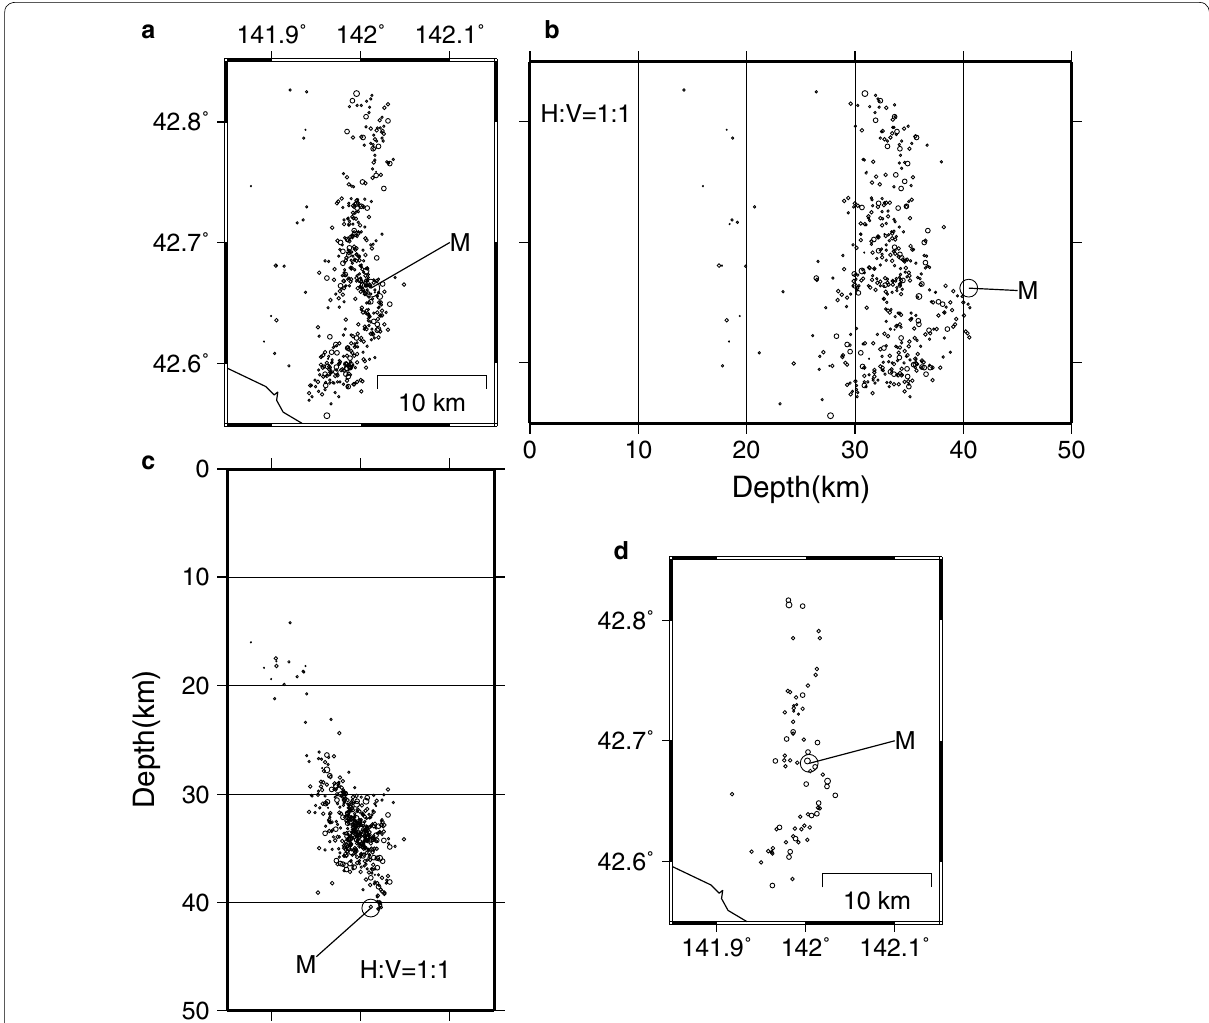
Fig. 2 Hypocenter distribution of the main shock and the aftershocks. a Distribution of epicenters determined by the tomoDD method from 2018-09-06 03:00 to 2018-09-07 23:59. A black line with “M” indicates the location of the main shock. The hypocenters are listed in Additional file 2. b , c Vertical cross sections of a in the N–S and E–W directions, respectively. d Distribution of epicenters determined by the homogeneous station method for 4 h immediately after the main shock from 2018-09-06 03:15 to 2018-09-06